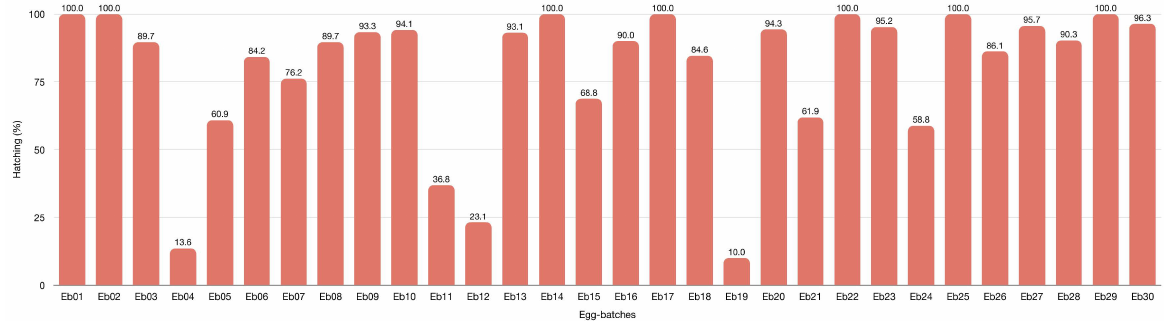
Figure 7. Hatching percentage of thirty egg batches laid after LABs mating, detailed in Table S2. Abbreviations: Eb =